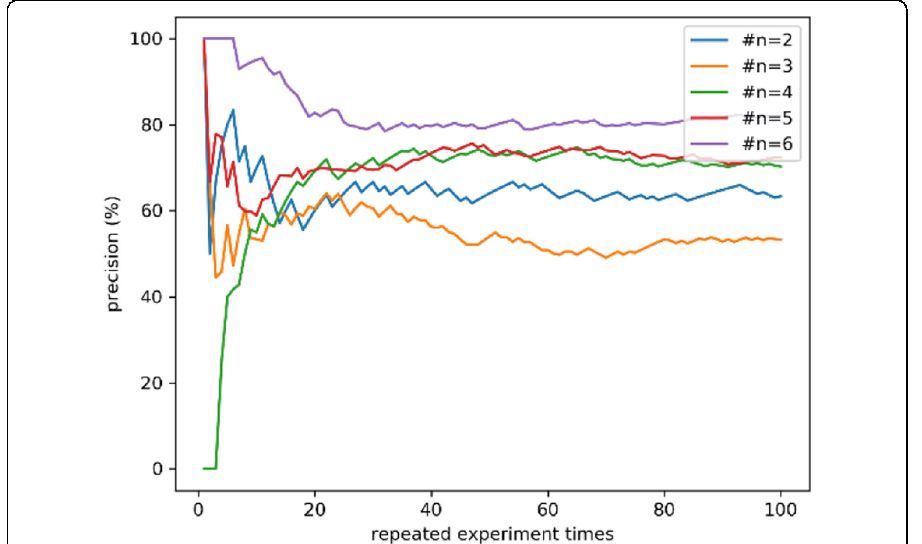
Fig. 4 The comparison of algorithm